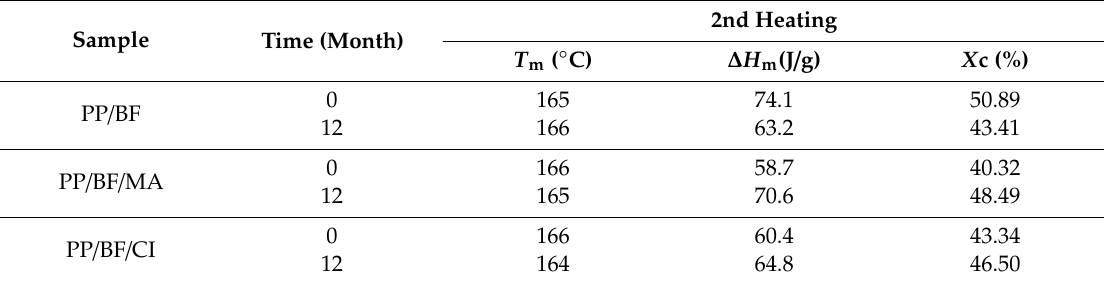
Table 5. Results of the thermal properties and crystallinity index obtained by DSC.